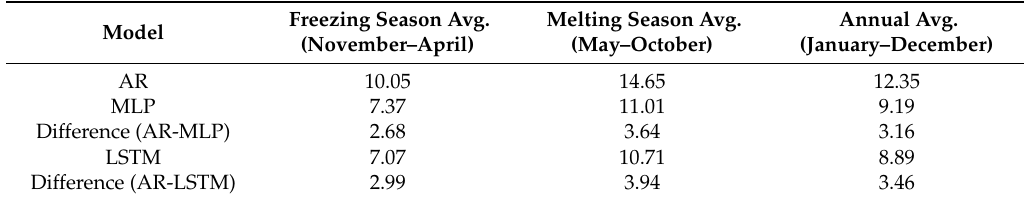
Table 5. Comparison of seasonal and annual RMSE values for autoregressive (AR) and deep learning (DL)